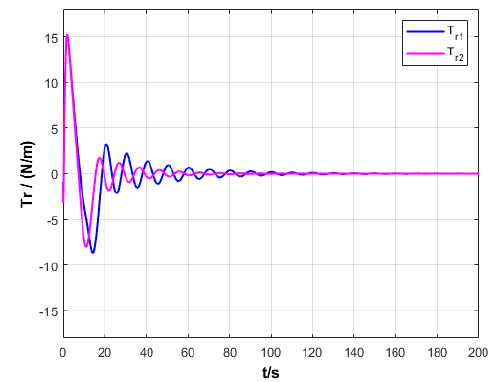
Figure 9. Turning torque of USV under two strategies.